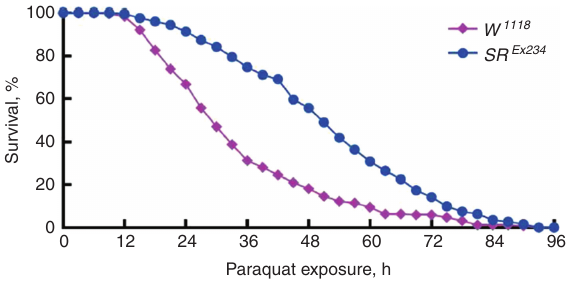
Figure 2: Sensitivity of the SR Ex234 mutant to paraquat. Survival curve of the SR-deficient fly in 20 mol/L paraquat. Survival rate of the paraquat-fed male flies was recorded every 3 h.